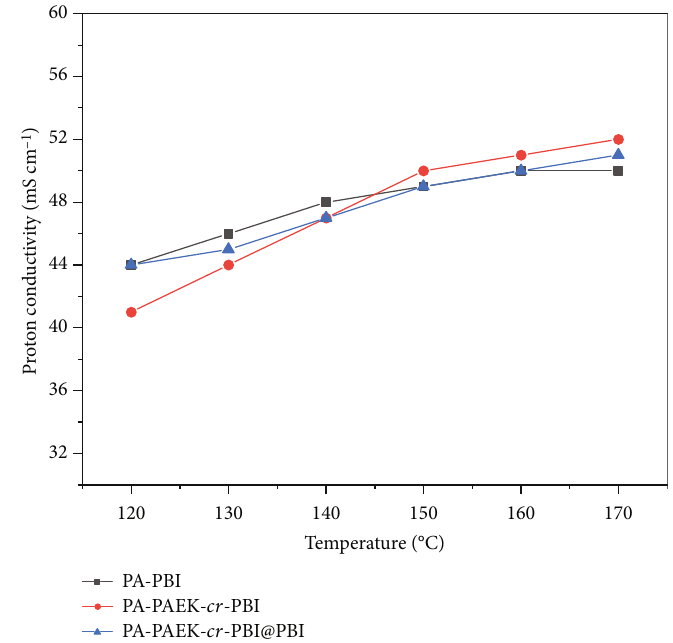
Figure 9: Proton conductivity of PA-doped